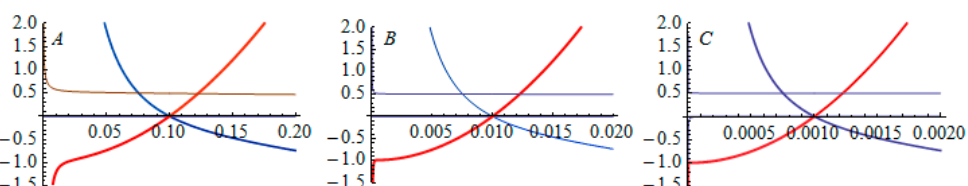
Figure 7. Red lines in graphs A , B , and C show that, with a decrease of increase of g u along the path in Equation (40)), the metric function )( xg gets closer to − 1 in the center. Values of g x are 0.1 ( A ), 0.01 ( B ), and 0.001 ( C ). The blue line is is )( xh .